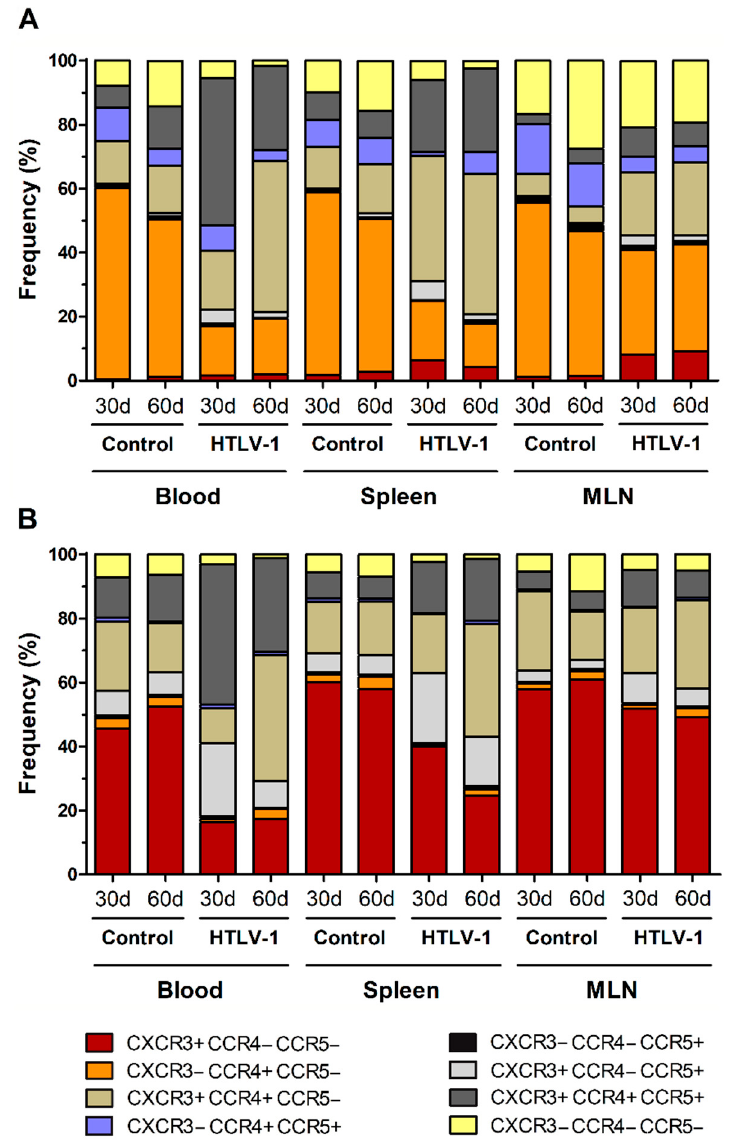
Figure 4. Expression of chemokine receptors in CD4 + and CD8 + T-cells. Blood, spleen, and mesenteric lymph nodes (MLN) from HTLV-1-infected and control HIS-NSG mice were collected at 30 days and 60 days from inoculation. Expression of CCR4, CCR5, and CXCR3 in ( A ) CD4 + and ( B ) CD8 + T-cells was evaluated by flow cytometry. Results are shown as mean frequency. Control groups 30 d and 60 d: n = 7; HTLV-1-infected group 30 d: n = 8; HTLV-1-infected group 60 d: n = 6.